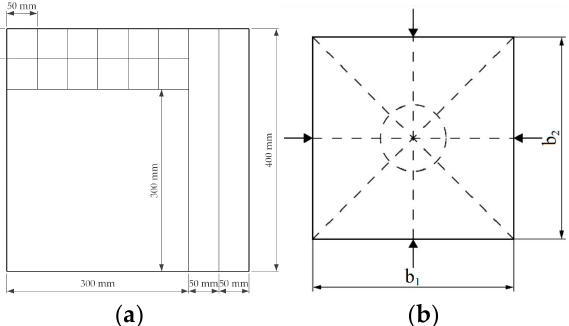
Figure 3. ( a ) Cutting scheme for boards produced in the study. ( b ) Scheme for determining the thickness of the samples.